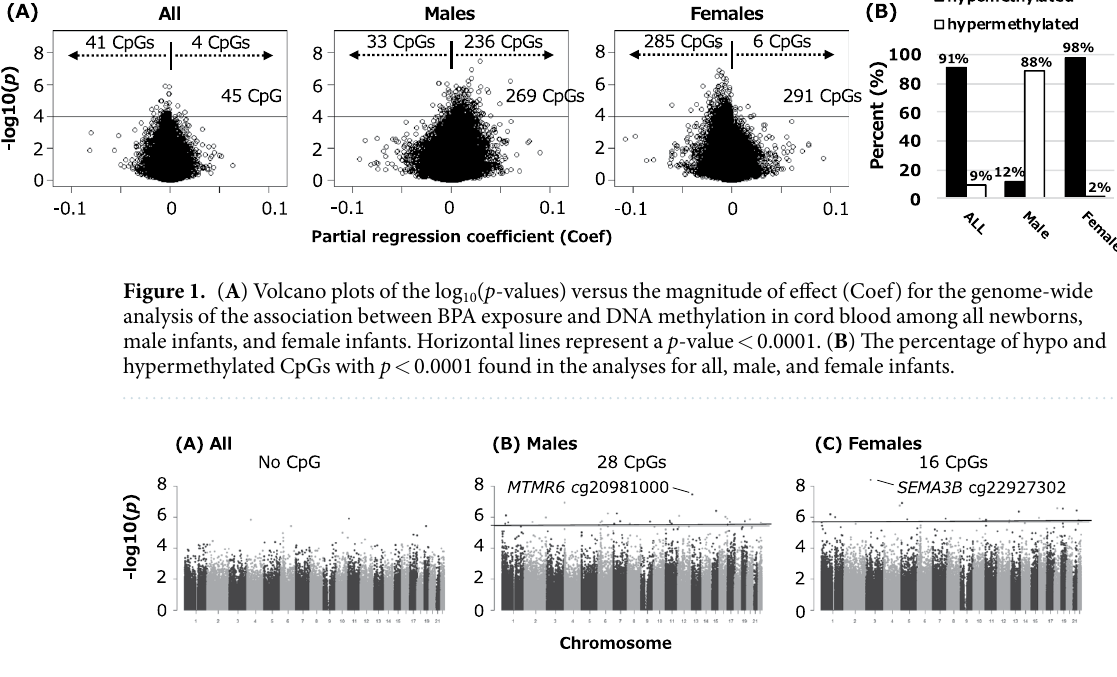
Figure 2. Manhattan plots of p -value associations between BPA exposure and DNA methylation across chromosomes in analyses for ( A ) all newborns, ( B ) male infants, and ( C ) female infants. Horizontal lines represent the significance threshold of FDR q <